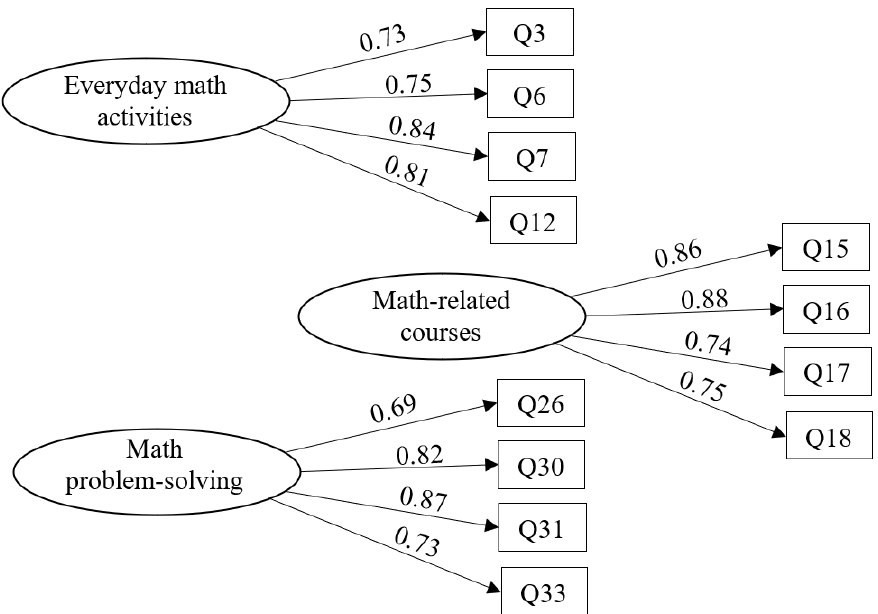
Figure 2. CFA resulting model on the adaptation process of the Mathematics Self-Efficacy Survey (MSES) to a Mexican–Spanish language instrument.